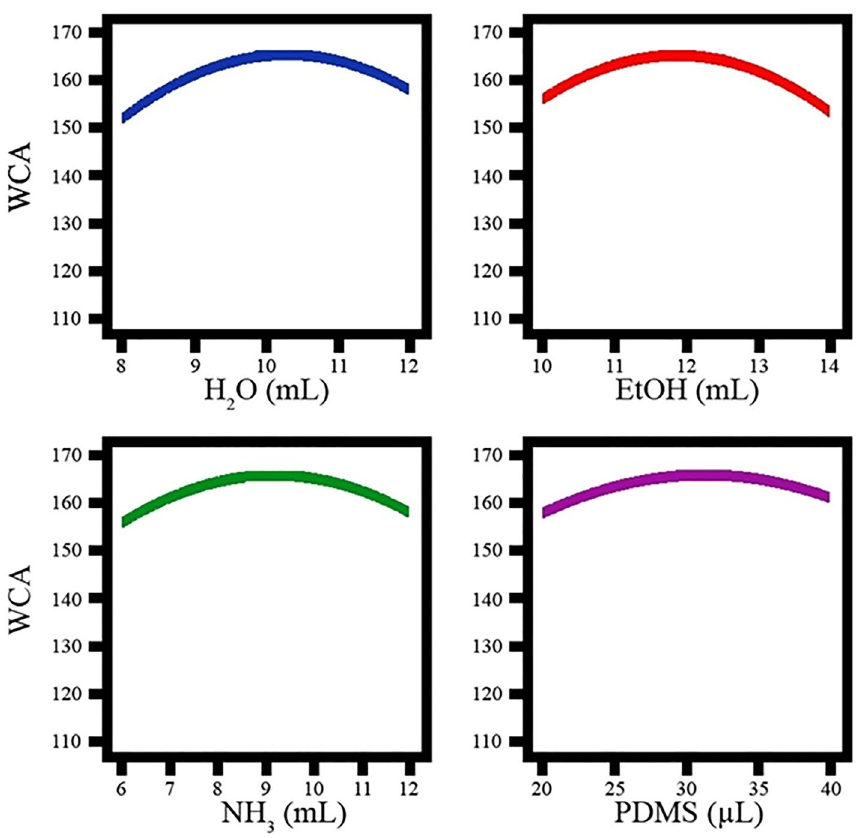
Figure 3. Influence of single variables on contact